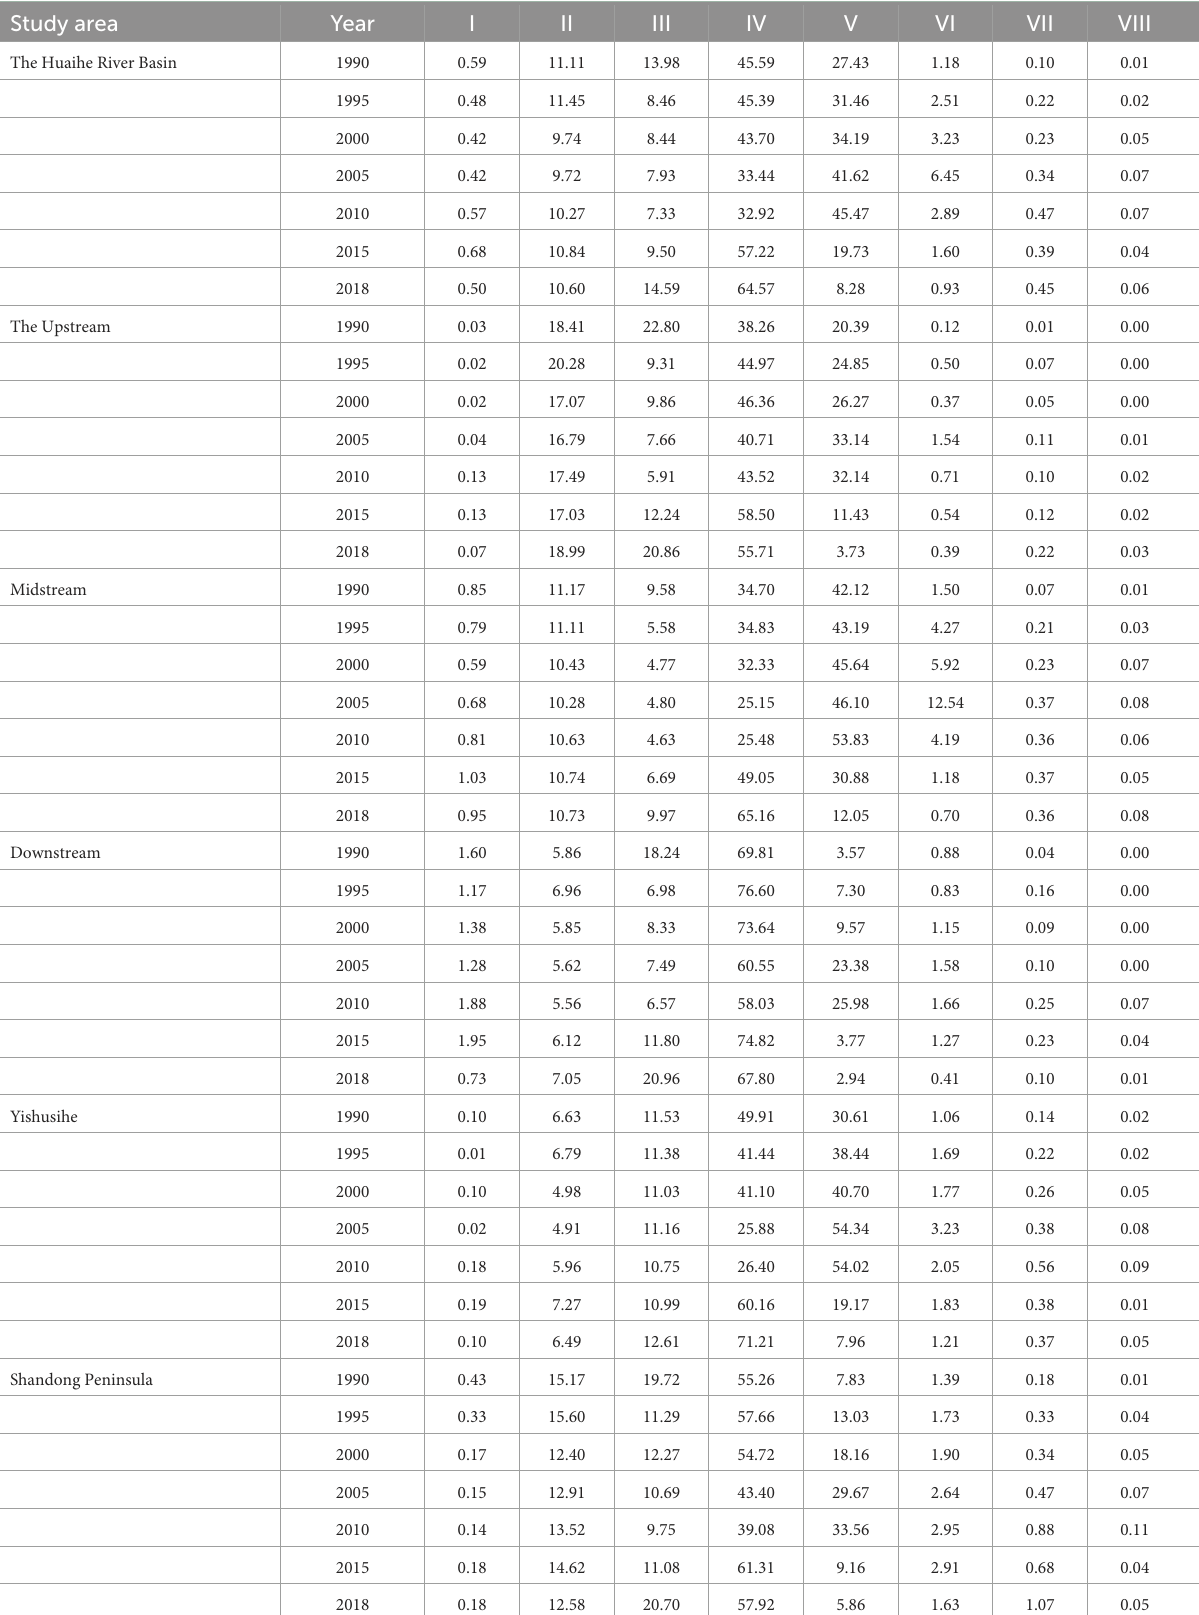
TABLE 4 Different levels of HDI in the Huaihe River Basin over the 1990–2018 period (%). Study